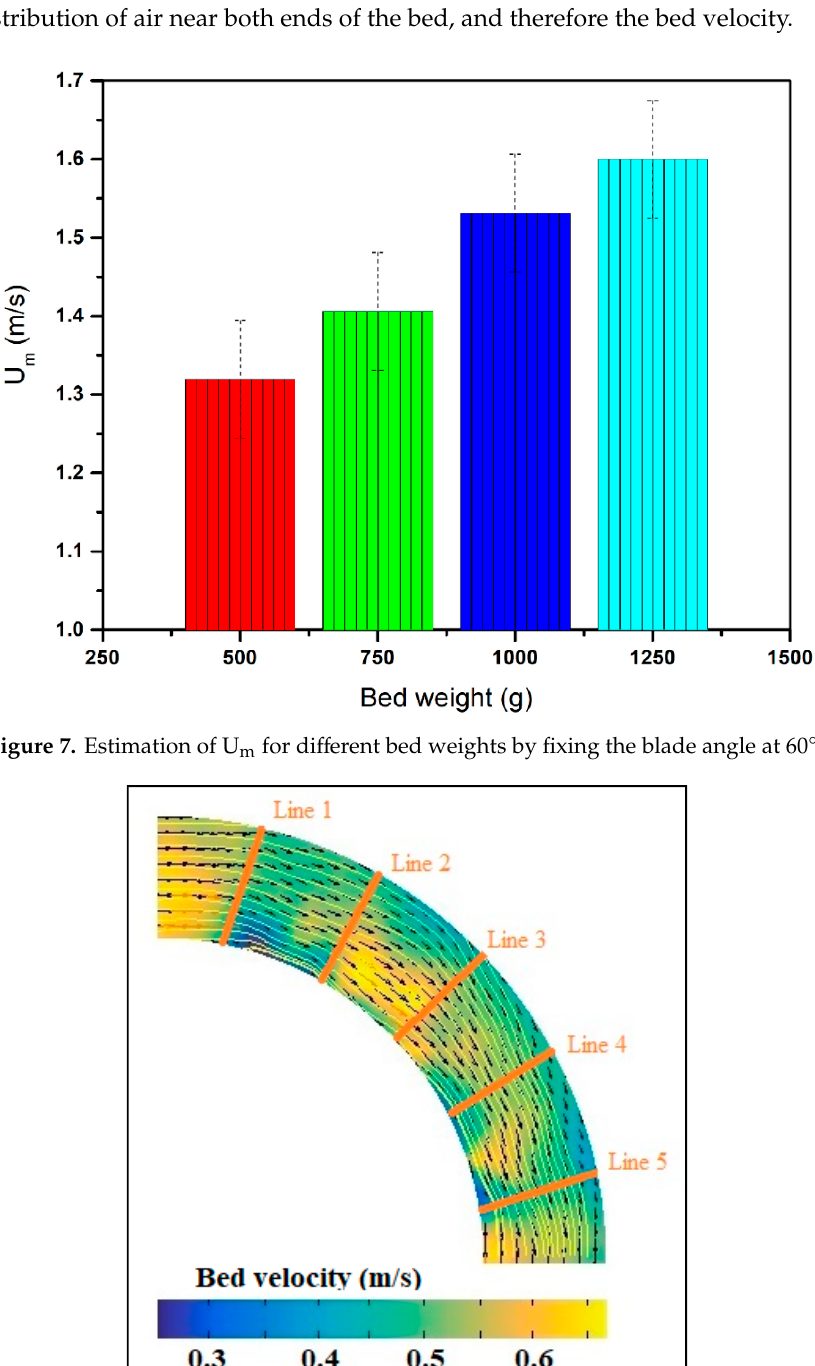
Figure 8. Marking of vector field for bed velocity measurements.